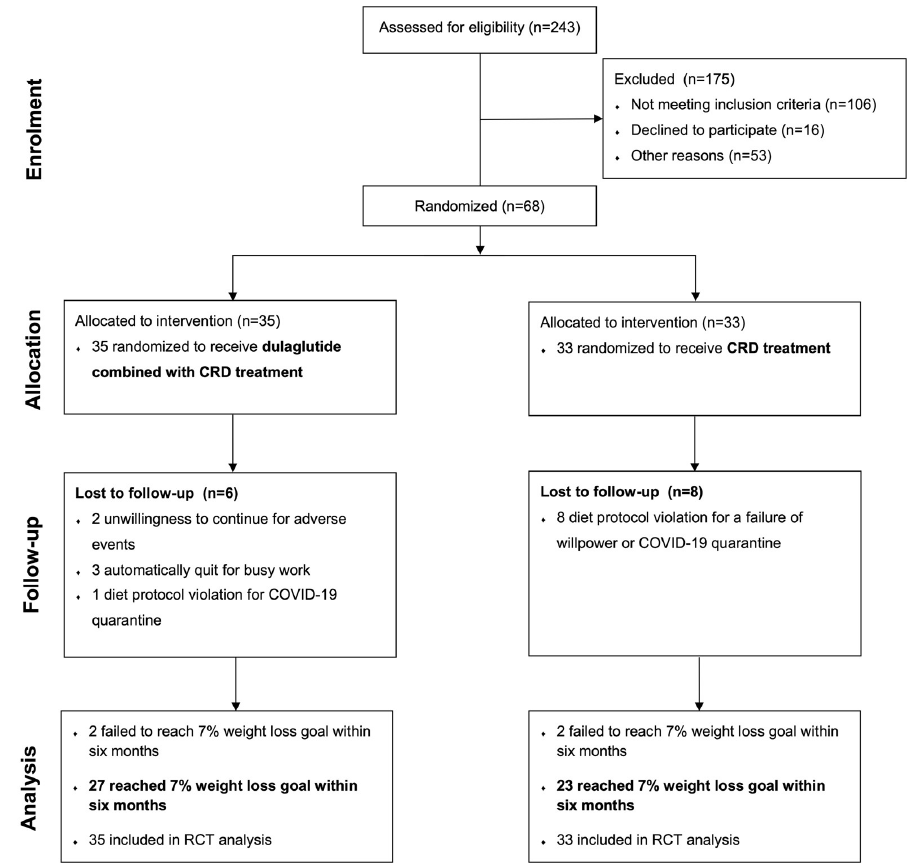
Figure 1. Flow diagram of this randomized, controlled, open-label trial. CRD, calorie-restricted diet. RCT, randomized controlled trial.